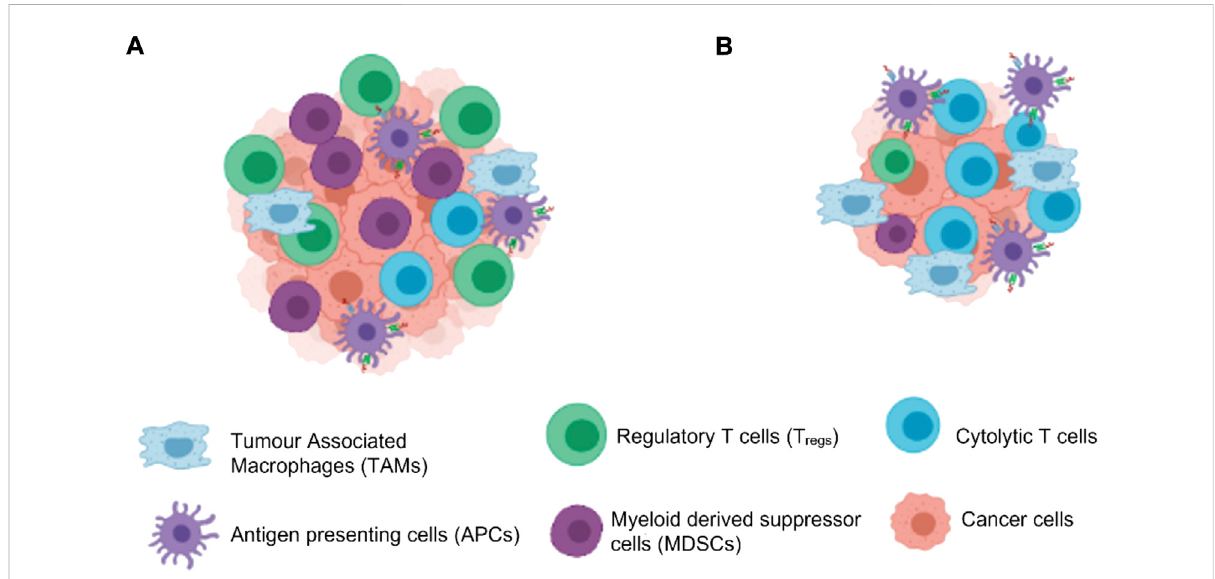
FIGURE 3 Cells in the tumour microenvironment. (A) High number of T regs and MDSCs help in proliferation of the tumour cells evading the immune surveillance (B) Use of immunotherapy can increase the CTL in the tumour microenvironment thereby leading to decrease in the tumour growth by cell apoptosis. (Created with